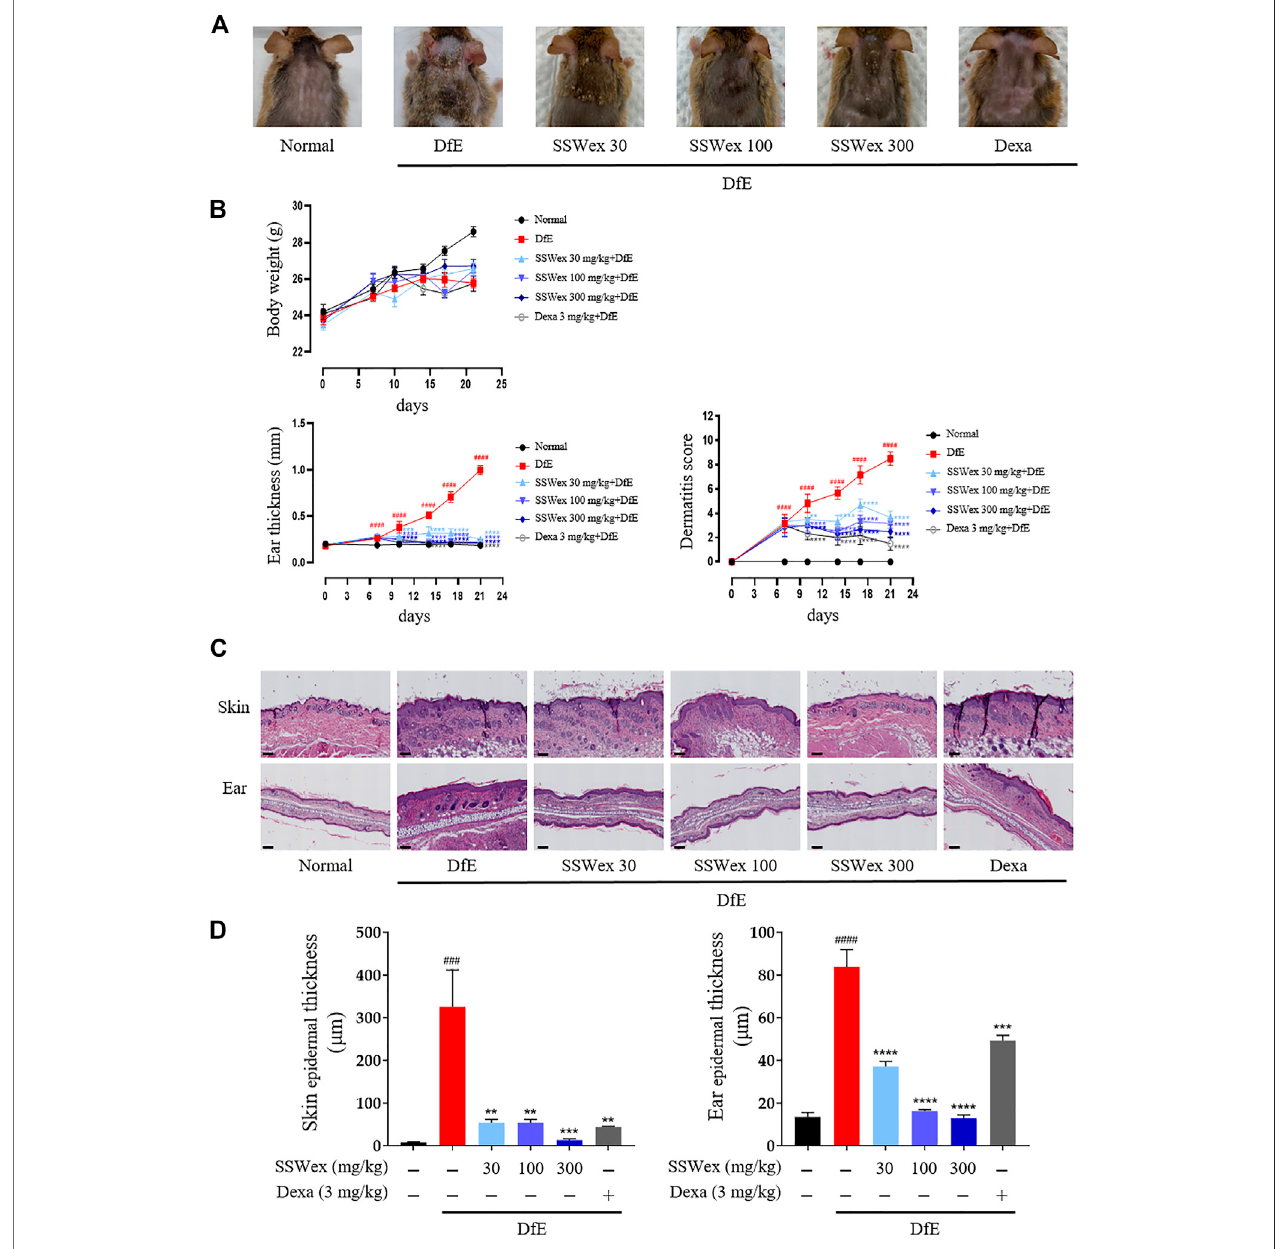
FIGURE 2 | Effect of SSWex on DfE-induced clinical and histopathological features of the AD-like skin lesions in NC/Nga mice. (A) Photographic images of the backs of mice from each group on the last day of the experiment. (B) Body weight, ear thickness, and dermatitis scores were measured twice a week for 3 weeks. (C) Skinandeartissuesectionswerestainedwithhematoxylinandeosin(H&E).Thestainedsectionswereobservedunderamicroscopeat×100magni fi cation.Scalebar= 100 μ m. (D) Skin and ear epidermis thicknesses of the DfE-treated NC/Nga mice were analyzed and represented as a graph. Values are presented as the mean ± S.E.M( n =6). # p < 0.05, ## p < 0.005, ### p < 0.0005,and #### p < 0.0001vs.thenormalgroup;* p < 0.05,** p < 0.005,*** p < 0.0005,and**** p <